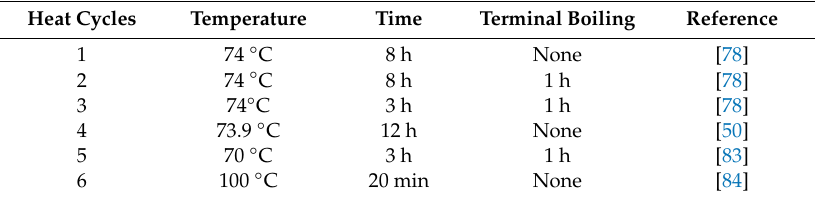
Table 3. Various heat cycles used for the polymerization of heat-cured PMMA.